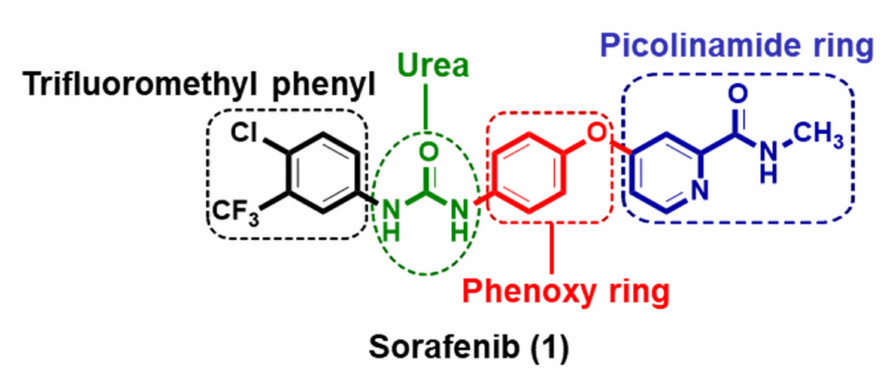
Figure 1. The chemical structure and the components of Sorafenib ( 1 ).